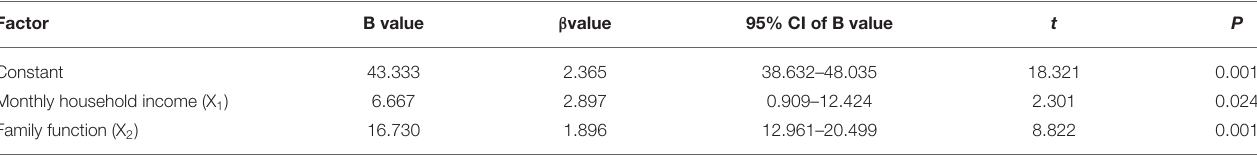
TABLE 4 | Linear regression analysis of the influence of various factors on the sense of psychological consistency of patients with type A